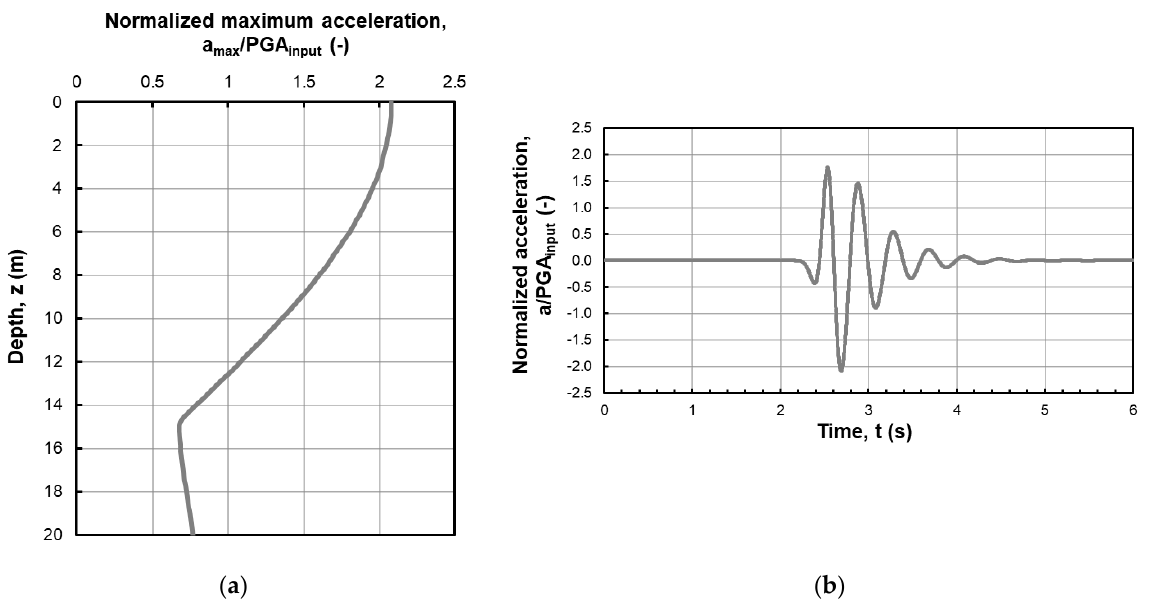
Figure 7. Normalized results: ( a ) profile of maximum acceleration as a function of the depth and ( b ) time history of acceleration at the ground level both normalized to the PGA of the input motion, PGA input (available in the Supplementary material S2).